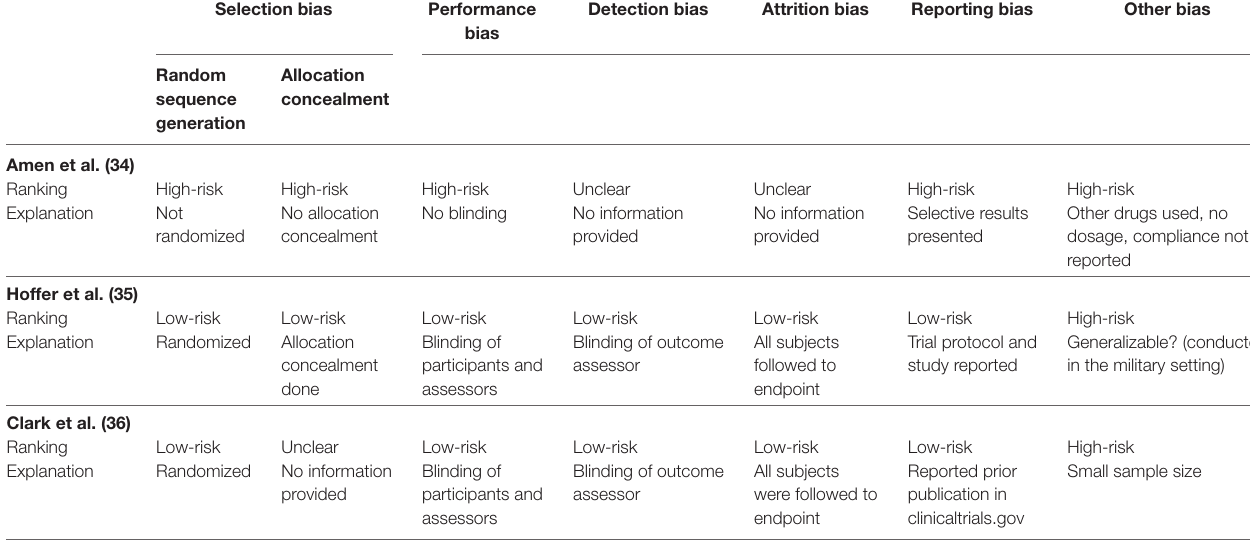
taBle 4 | Risk of bias in human trials assessing the role of N -acetylcysteine for traumatic brain